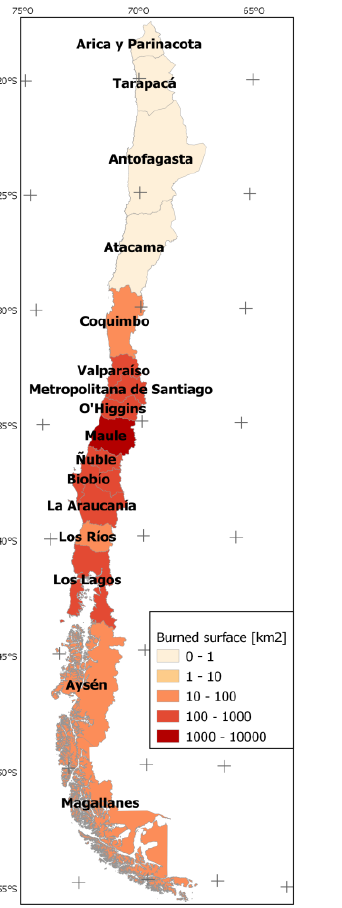
Figure 5. Total burned surface by region.